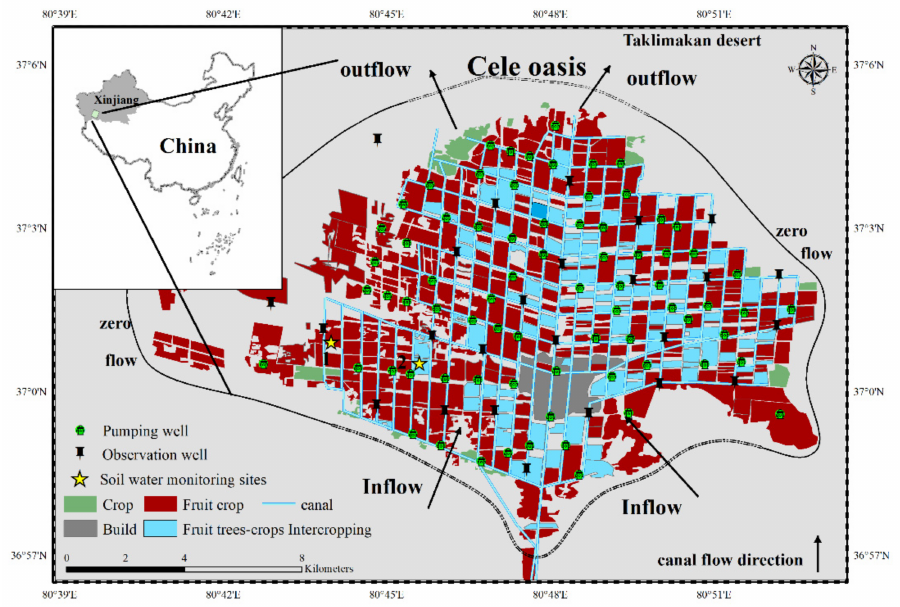
Figure 1. Location of the study area (Cele Oasis) and division areas of cropping structure. The canal system inside the oasis is developed, forming a typical artificial farmland oasis landscape. The direction of flow of the groundwater aquifer in the oasis is the same as that of the surface flow. The buried depth of groundwater is less than 50 m, and the aquifer is a quaternary pore phreatic water system. The soil type in the study area is loamy sand, which has a high infiltration rate. In recent years, due to the impact of climate change and human activity, the agricultural cropping structure of the oasis has changed greatly, which has greatly affected the safety of the